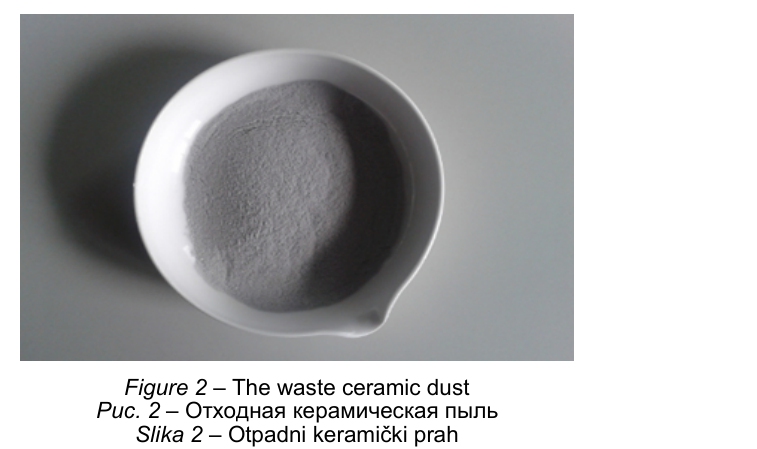
Figure 2 – The waste ceramic dust Рис . 2 – Отходная керамическая